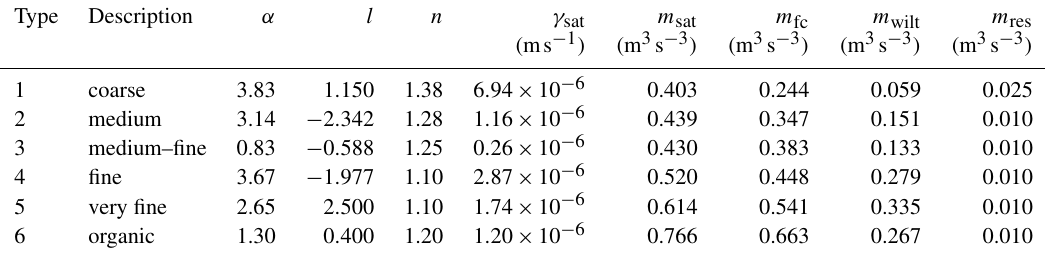
Table 2. Lookup table for soil parameters.